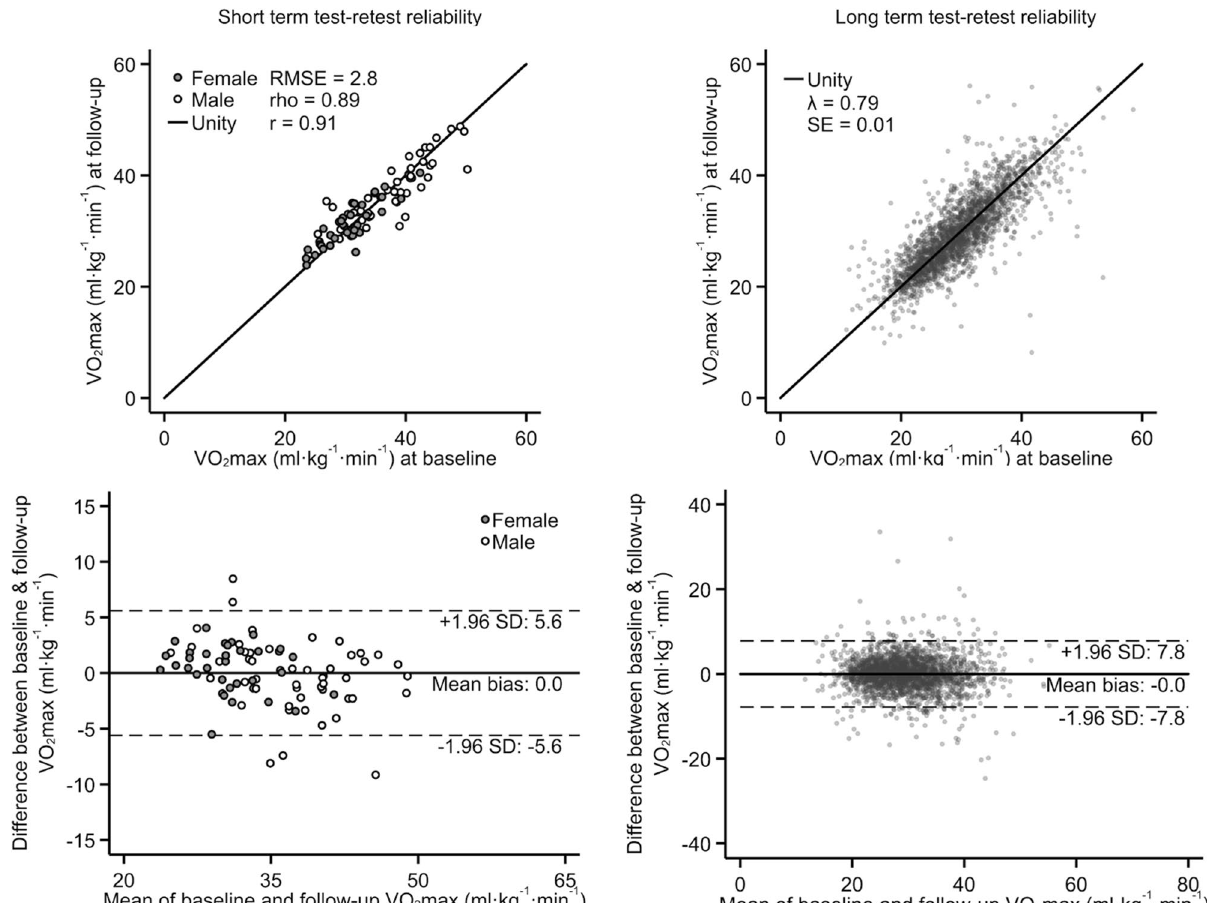
Figure 4. Scatterplots (top row) and Bland–Altman plots (bottom row) demonstrating short- and long-term test–retest reliability. r: Pearson’s correlation coefficient, rho: Spearman’s rank correlation coefficient. RMSE: Root-mean-square error. Lamda: Regression-dilution coefficient. SE: Standard error. Short-term reliability data are from the validation study (n = 87, follow-up ~ 10 days) and long-term reliability data are from the repeat- measures sub-study in UK Biobank (n = 2877, follow-up ~ 2.8